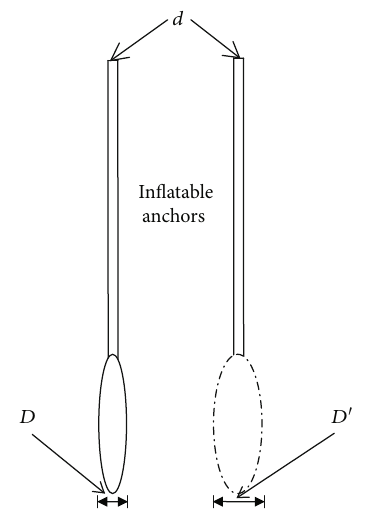
Figure 10: Deformation diagram of the rubber after